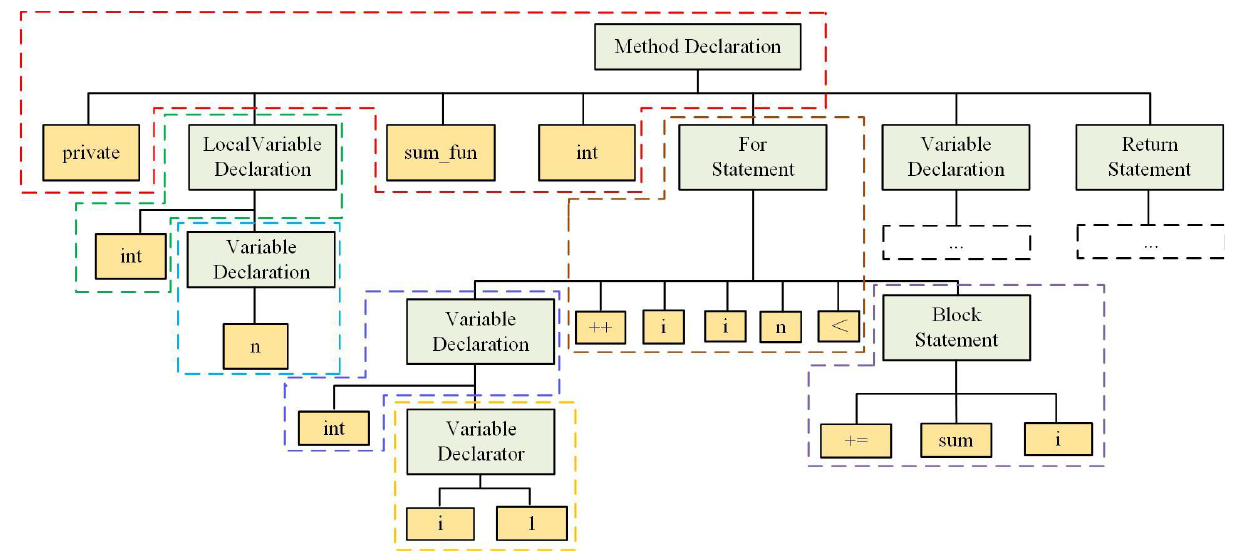
Figure 3. The simplifying and grouping process of the target abstract syntax tree. The attribute nodes are removed and the size of the tree is significantly reduced. Declaration or Statement nodes and their leaf nodes are grouped into the same group. Dotted boxes with different colors indicate different groups.